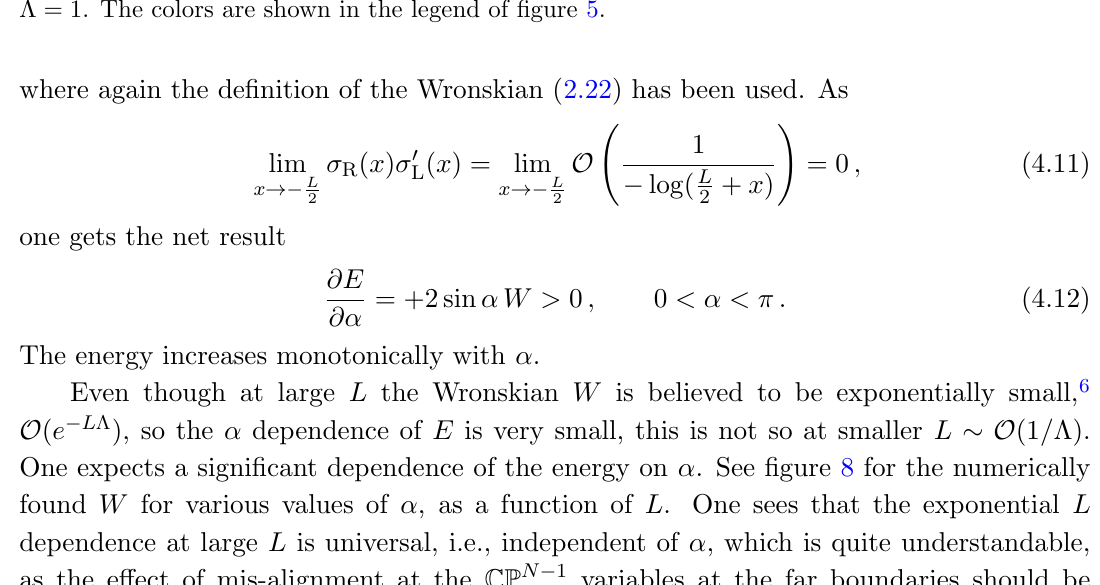
Figure 8. The Wronskian (2.22) is numerically evaluated for various (cid:11) , as a function of L for (cid:3) = 1. The colors are shown in the legend of (cid:12)gure